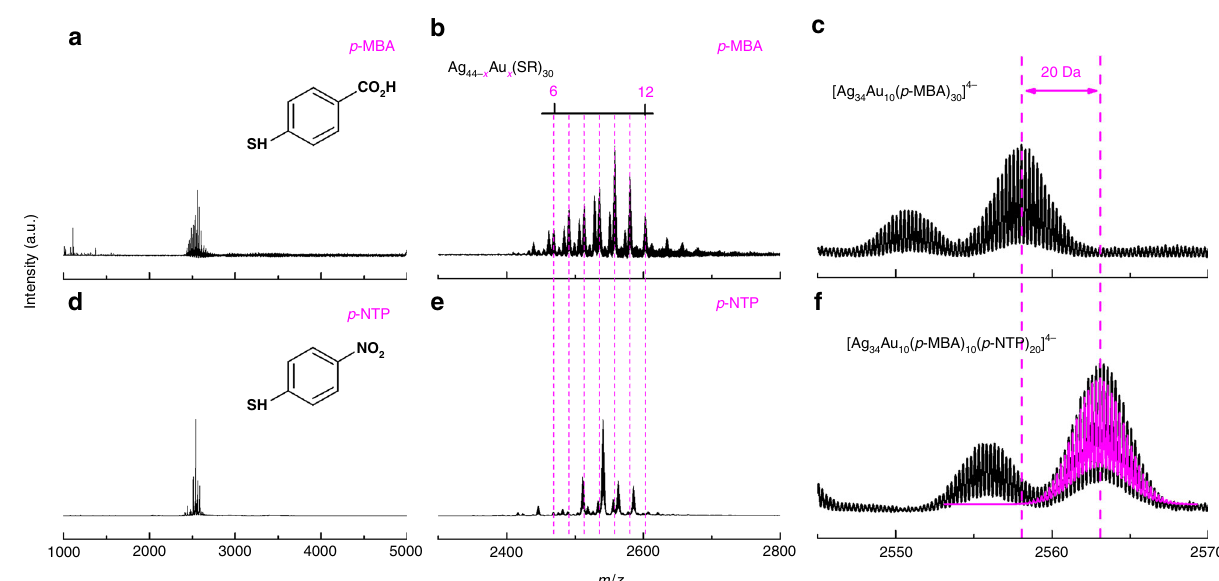
Fig. 5 Ag@Au nanoclusters produced with different Au(I) – SR complexes. Electrospray ionization mass spectra of [Ag 44- x Au x (SR) 30 ] 4 − nanoclusters (SR denotes thiolate ligand) synthesized by using a – c Au(I) – ( p -MBA) complexes ( p -MBA = para -mercaptobenzoic acid) and d – f Au(I) – ( p -NTP) complexes ( p -NTP = para -nitrothiophenol): a , d mass spectra in a broad m/z range of 1000 – 5000; b , e zoom-in mass spectra in m/z = 2200 – 2800; and c , f isotope patterns of [Ag 34 Au 10 (SR) 30 ] 4 − . The dotted drop lines in b , e indicate the number of Au heteroatoms in each cluster. The magenta line in f is the